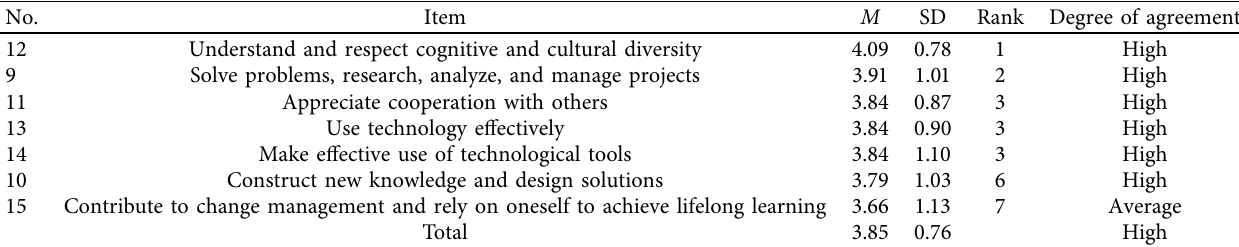
Table 11: Descriptives of lifelong learning skills in descending